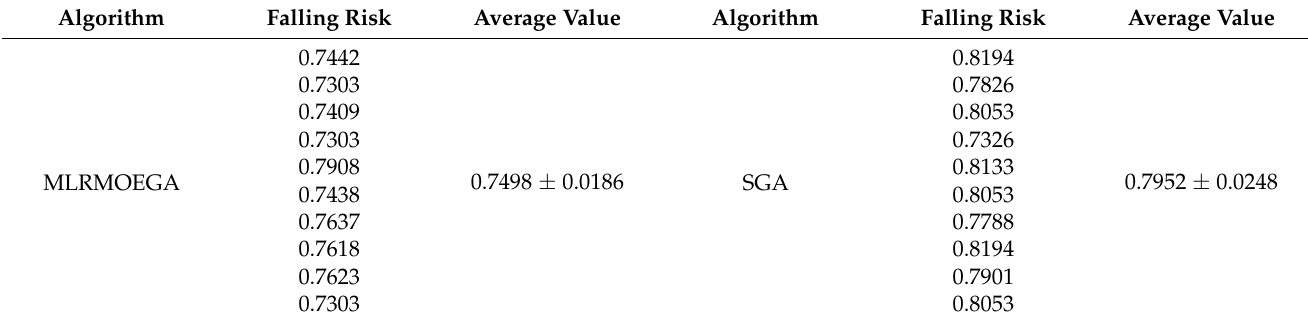
Table 3. Results of Artificial Potential Field Theory Experiment (with 20 × 20 grid